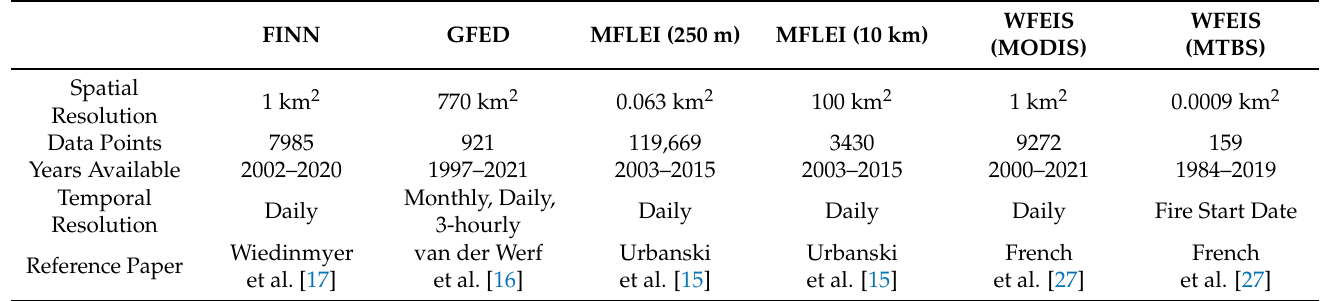
Table 1. Summary of fire emissions inventory characteristics: spatial resolution, number of data points for emissions estimates in 2013, the years of available data, temporal resolution, and the reference for the fire emissions inventory are